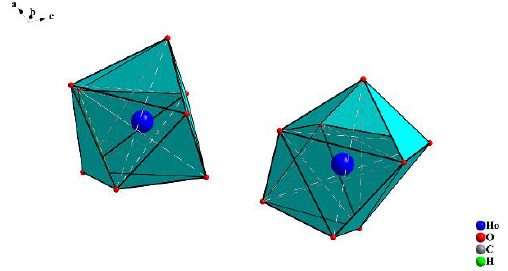
Figure 2. The coordination polyhedra of the holmium atoms.